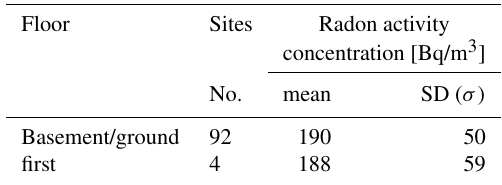
Table 3. Mean value of radon activity concentrations in indoor air according the zone-type.